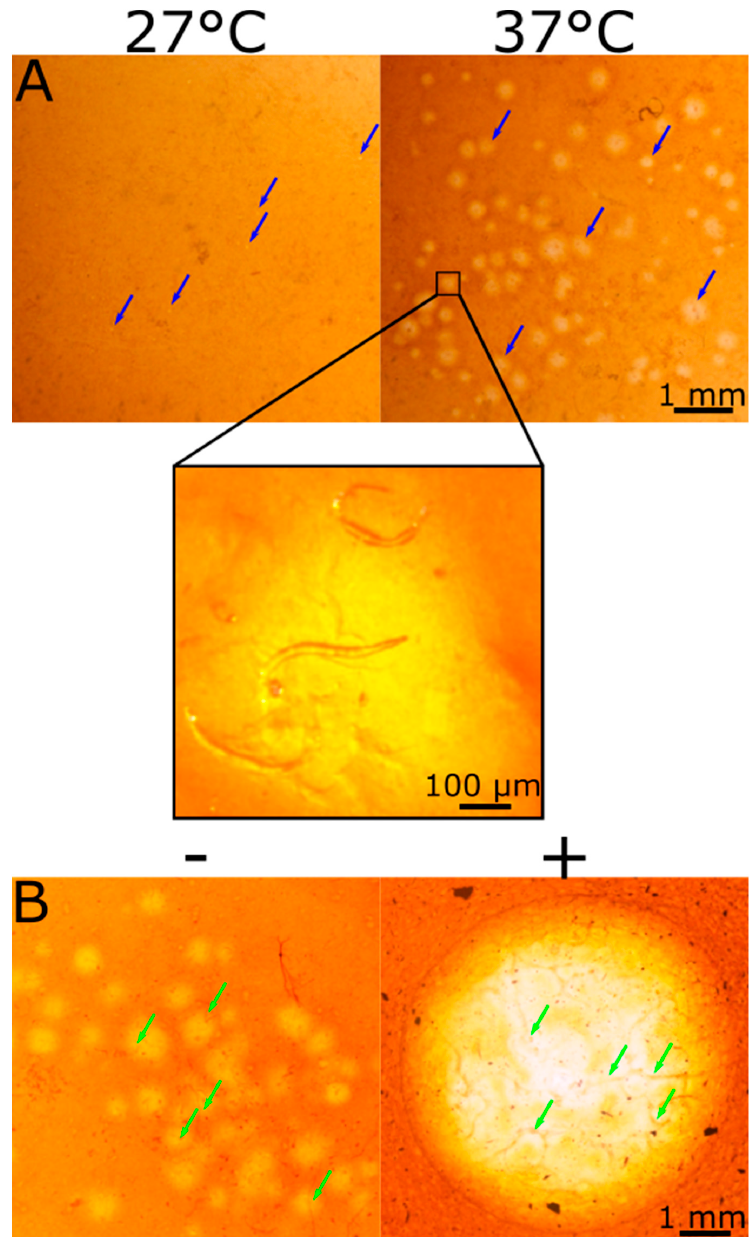
Figure 5. CMC hydrolysis by Root knot nematodes. Approximately 80 nematodes in 50 μ L were applied to the center of a dyed CMC film without ( A ) or with ( B ) root extract. ( A ) The films were incubated for 2 h at either 27 °C—the ideal temperature for RKN (left), or 37 °C—the ideal temperature for the CMC hydrolysis reaction (right). The films were washed and visualized. In both temperatures, hydrolysis could be visualized in the form of many spots of color change (marked with blue arrows). The spots on the film incubated at 37 °C were larger and clearer due to the higher efficiency of the hydrolysis reaction in that temperature. An enlargement of one of the spots clearly shows the nematodes located in that spot. ( B ) A comparison between the visualization of cellulase secretion by RKN on a film containing (right side, marked with+) and not containing (left side, marked with − ) root extract. The addition of root extract to the film resulted in a clear halo as opposed to the singular spots on the film not containing the root extract, which was probably due to increased cellulase secretion. The nematodes are marked with green arrows.